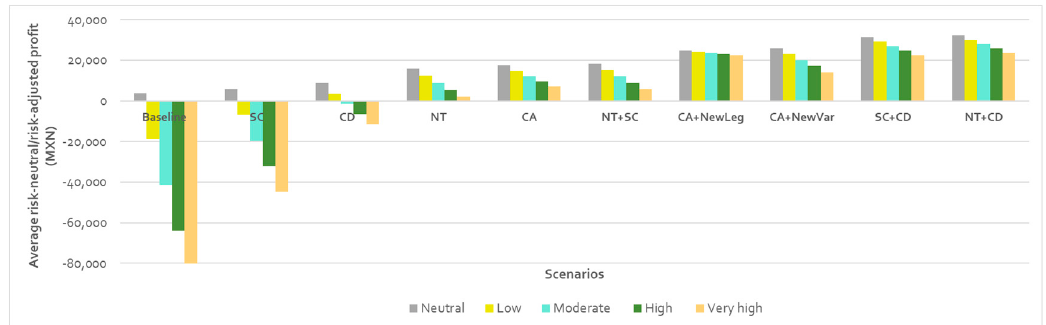
Figure 5. Average risk-neutral profit (gray bars) and associated risk-adjusted profit for the 10 scenarios across four levels of farmer risk aversion (low–yellow bars; moderate–blue bars; high–green bars; and very high–orange-brown bars) for the representative farm (T6) in southern Guanajuato. Scenarios are ranked by risk-neutral profit.